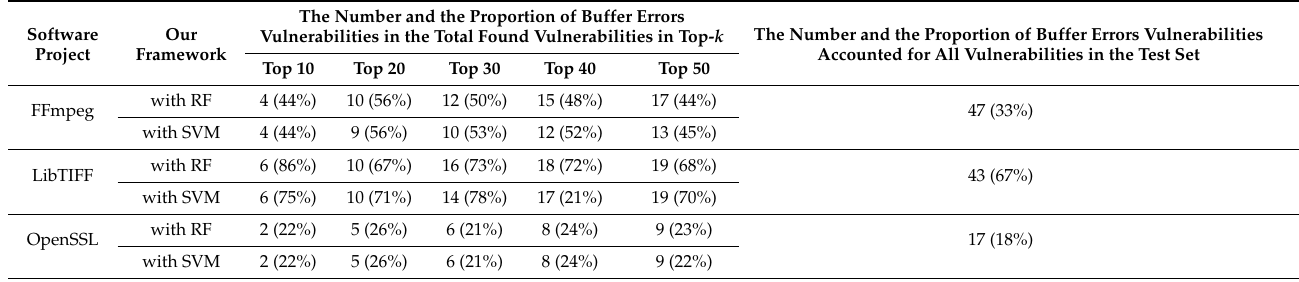
Table 5. The number and the proportion of buffer errors (CWE-119) vulnerabilities accounted for in the found vulnerabilities in Top- k on projects: FFmpeg, LibTIFF, and